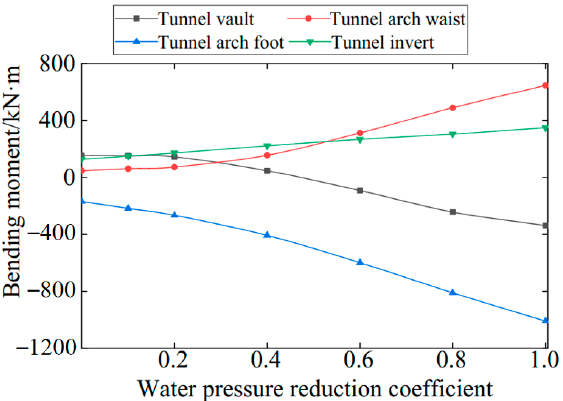
Figure 9. The relationship between bending moment and water pressure reduction coefficient.